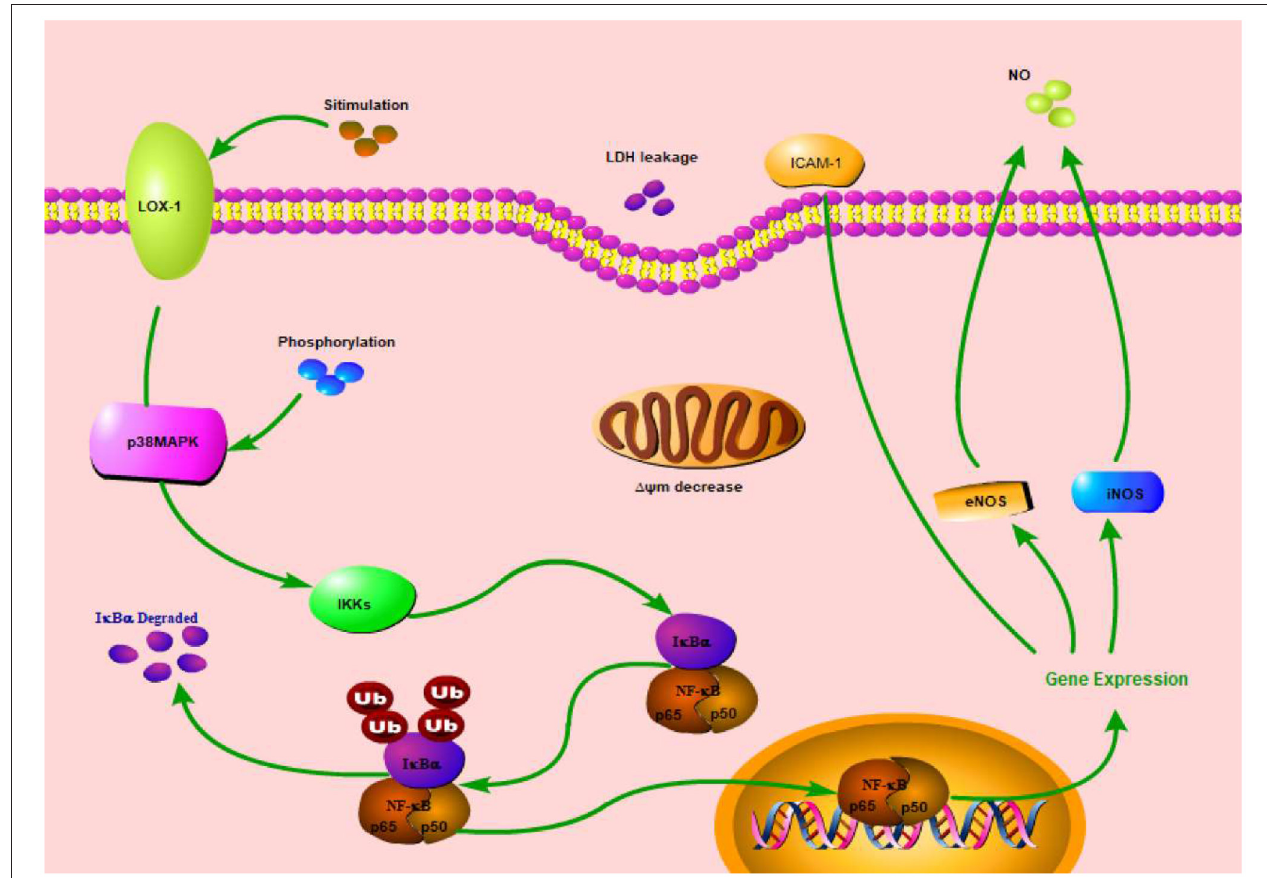
FIGURE 4 | Simplified p38MAPK/NF- κ B signal pathway